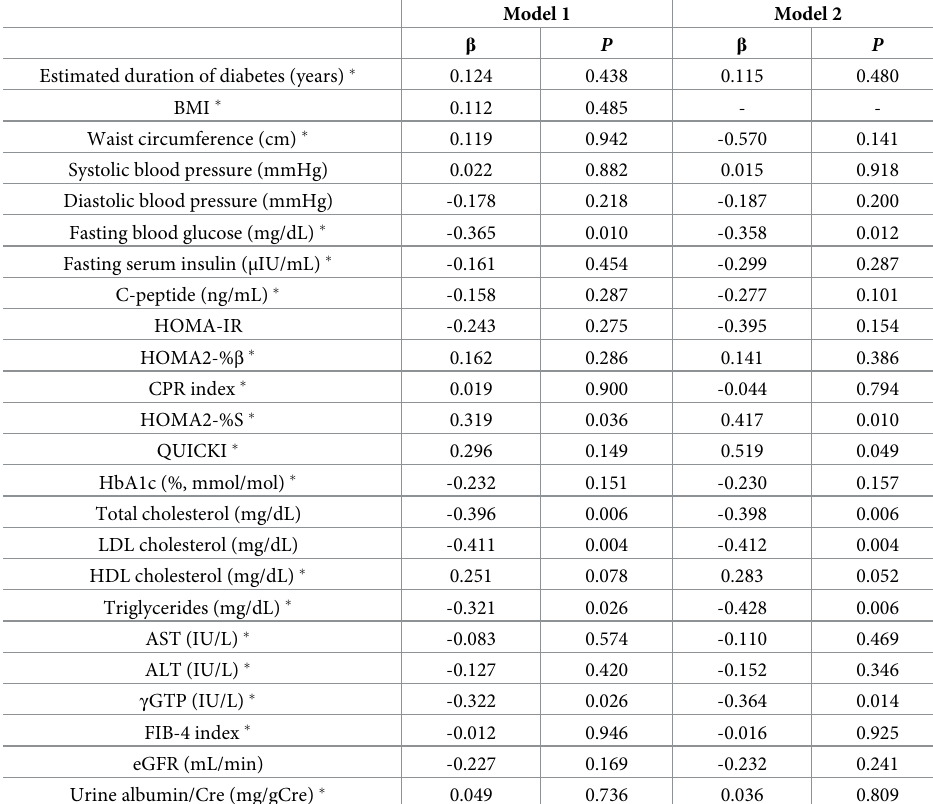
Table 3. Multivariate linear regression analyses for serum SerpinB1 levels in T2DM